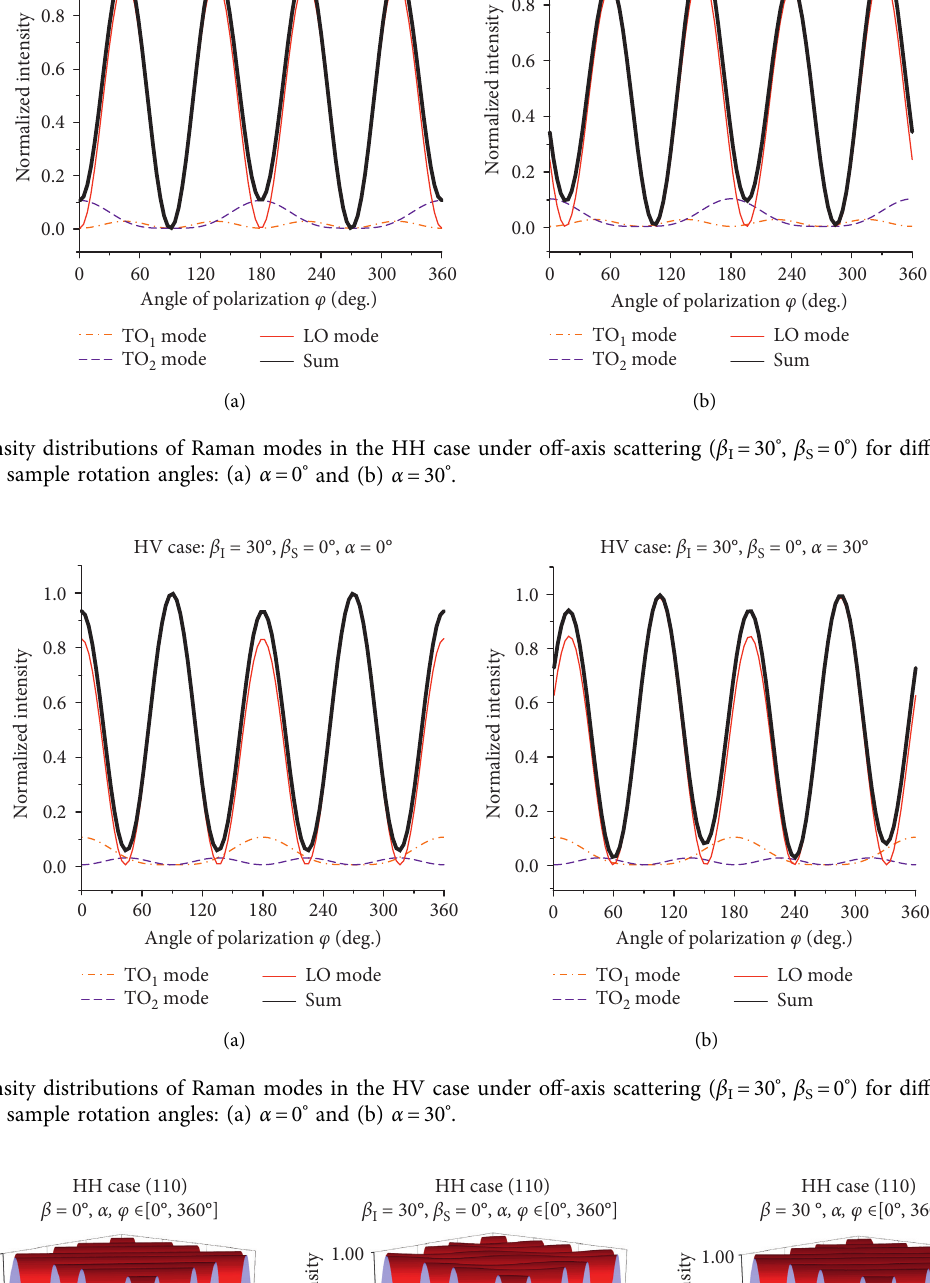
� 30 ° , β � 0 ° ) for different polarization I S